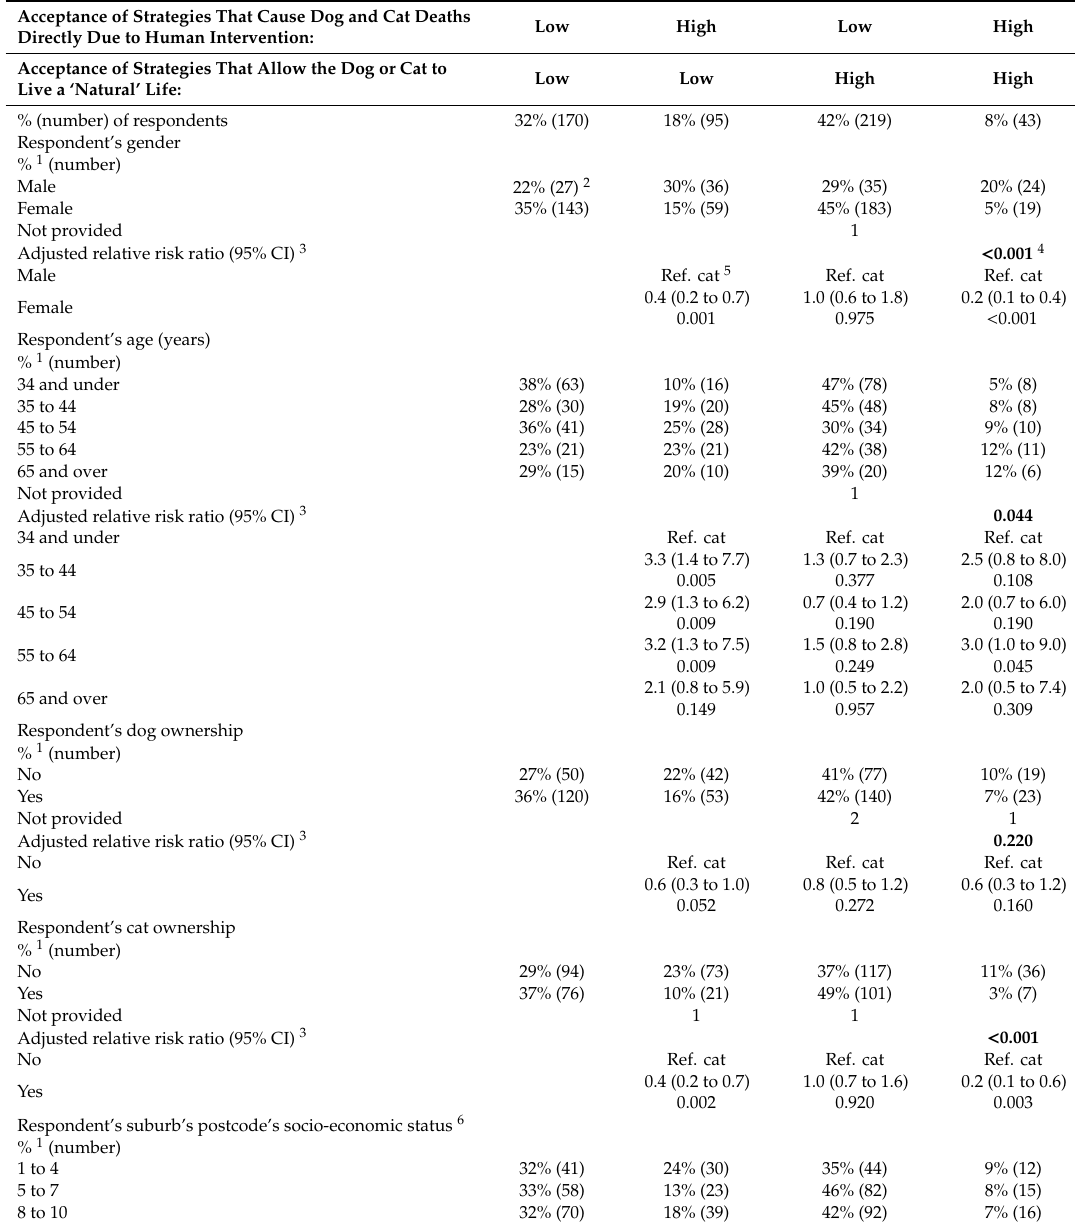
Table 6. Associations between socio-demographic variables (independent variables) and respondents’ collective views about the acceptability of various strategies for reducing or preventing wild dog and cat predation on wildlife (the response or dependent variable). Each respondent was classified into one of four dependent variable categories: low or high acceptance of strategies that cause dog and cat deaths directly due to human intervention, and low or high acceptance of strategies that allow the dog or cat to live a ‘natural’ life ( n =